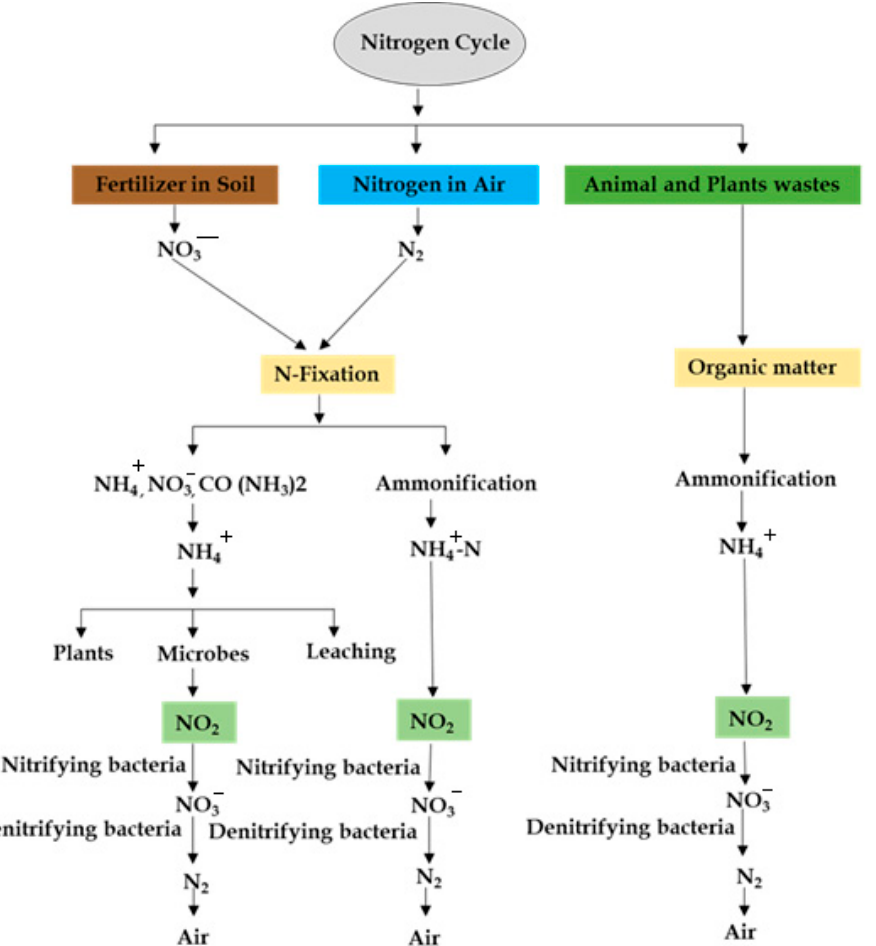
Figure 2. Nitrogen cycle indicating leaching of excessive nitrogen through different